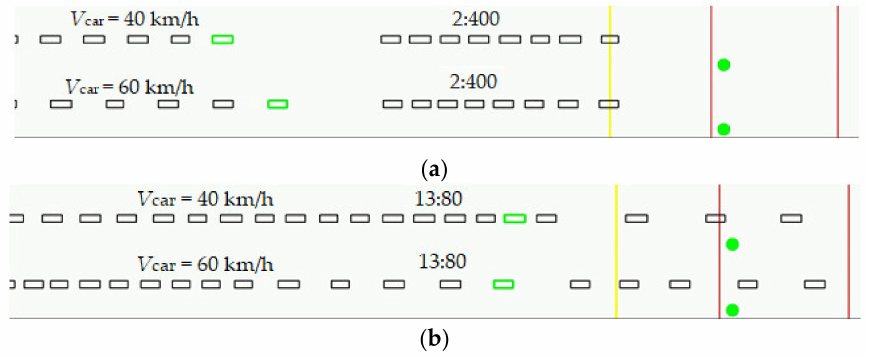
Figure 6. Simulation visualization of vehicles movement at an intersection ( a , b ) ( CarMeter = 8, S 1 = 140 m).